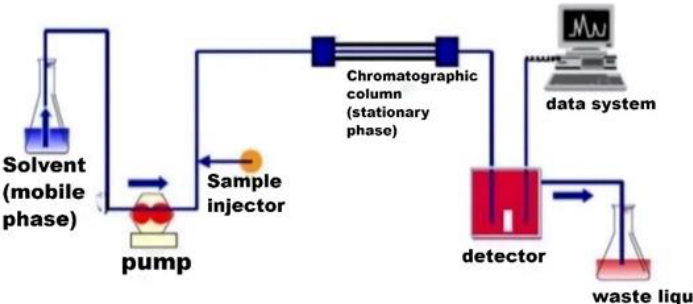
Figure 2. Detection flow chart of HPLC.